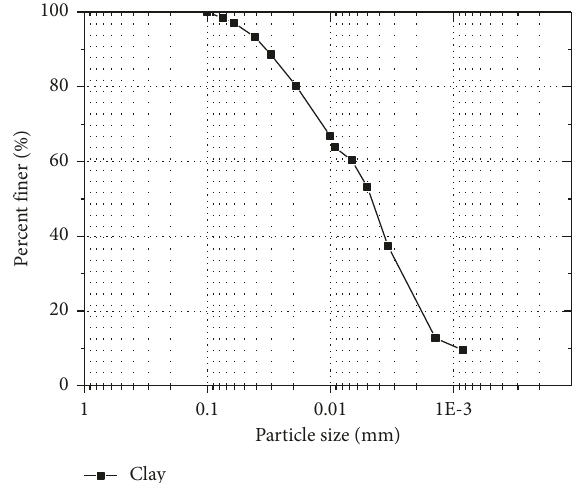
Figure 3: Particle-size distribution curve of a typical Tianjin clay.